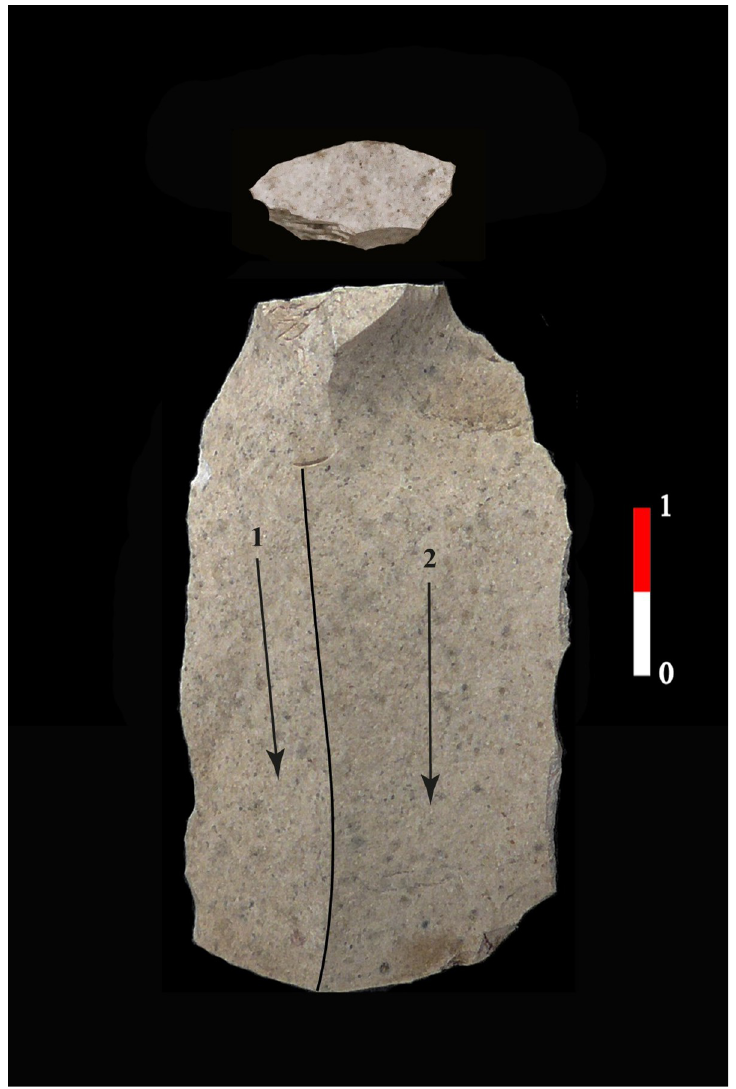
Fig 10. Example of blade of the group 1 in the H380 of Cuiry-l è s-Chaudardes, (CCF, 378–44583, Soissons, France).